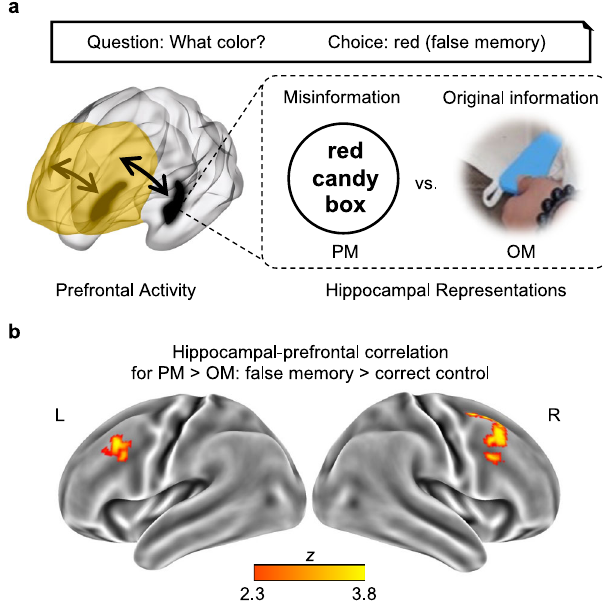
Fig. 5 | Prefrontal activity correlates with hippocampal representations when falsememoryoccurs.a Thehypothesiswasthatprefrontalactivitywouldbemore positively correlated with hippocampal representation of post-event misinforma- tion (PM) than that of original information (OM) when false memory occurred during the memory test. The prefrontal cortex is shown in yellow, and the hippo- campus is shown in black. Permission has been obtained from the individual to appear in this fi gure. b The lateral prefrontal activity showed a more positive cor- relation with hippocampal item-speci fi c representation of post-event information than with that of original information, and this effect was more pronounced for false memory than for correct control during the memory test in Exp. 2 ( N